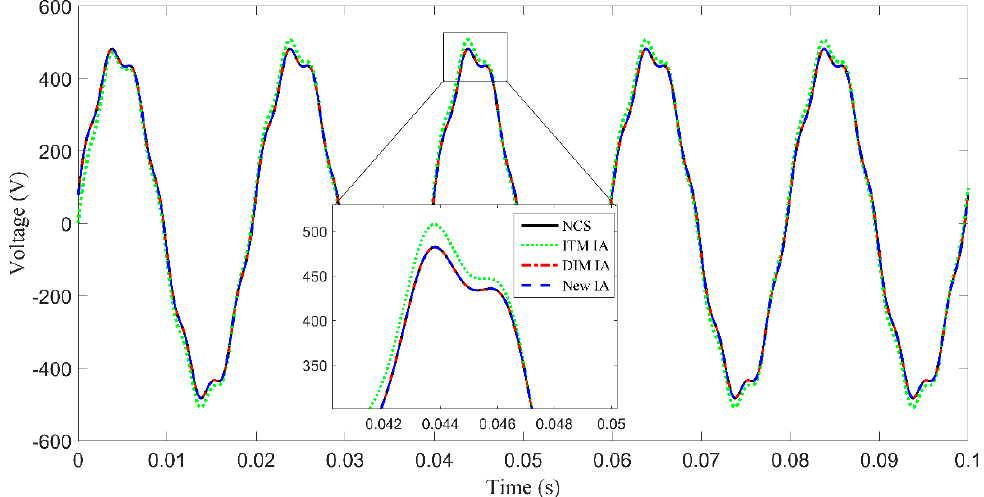
Figure 5. Voltage waveform of the DSS side by using the new IA.